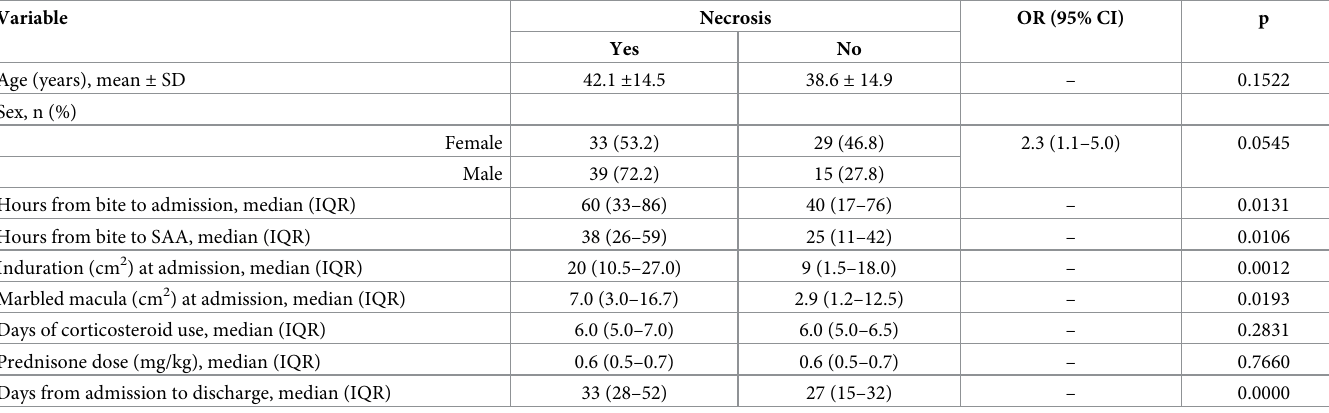
Table 4. Comparison between patients who developed skin necrosis and those who did not.